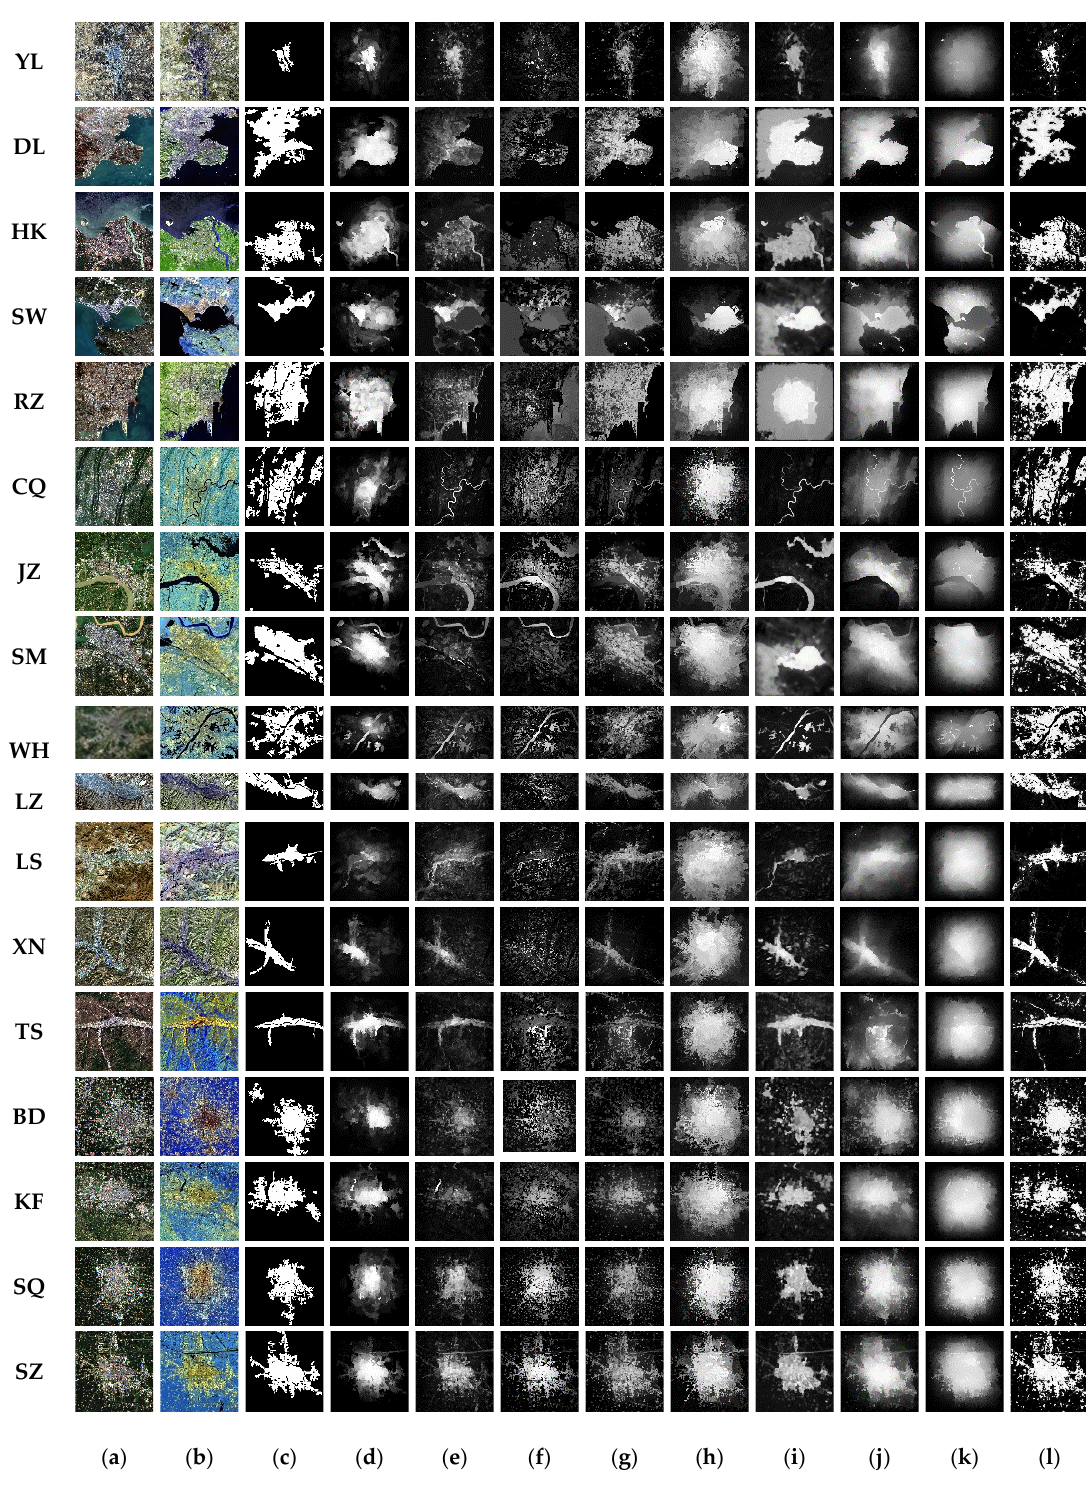
Figure 4. Saliency maps produced by our proposed model and eight competing models. ( a ) Original images; ( b ) optimal band combinations; ( c ) ground truth; ( d ) dense and sparse reconstruction (DSR); ( e ) discriminative regional feature integration (DRFI); ( f ) regional principal color (RPC); ( g ) diffusion-based compactness and local contrast (DCLC); ( h ) inner and inter label propagation (LPS); ( i ) bootstrap learning (BL); ( j ) diffusion process on a two-layer sparse graph (DPTLSG); ( k ) reversion correction and regularized random walks ranking (RCRR); ( l ) Ours.